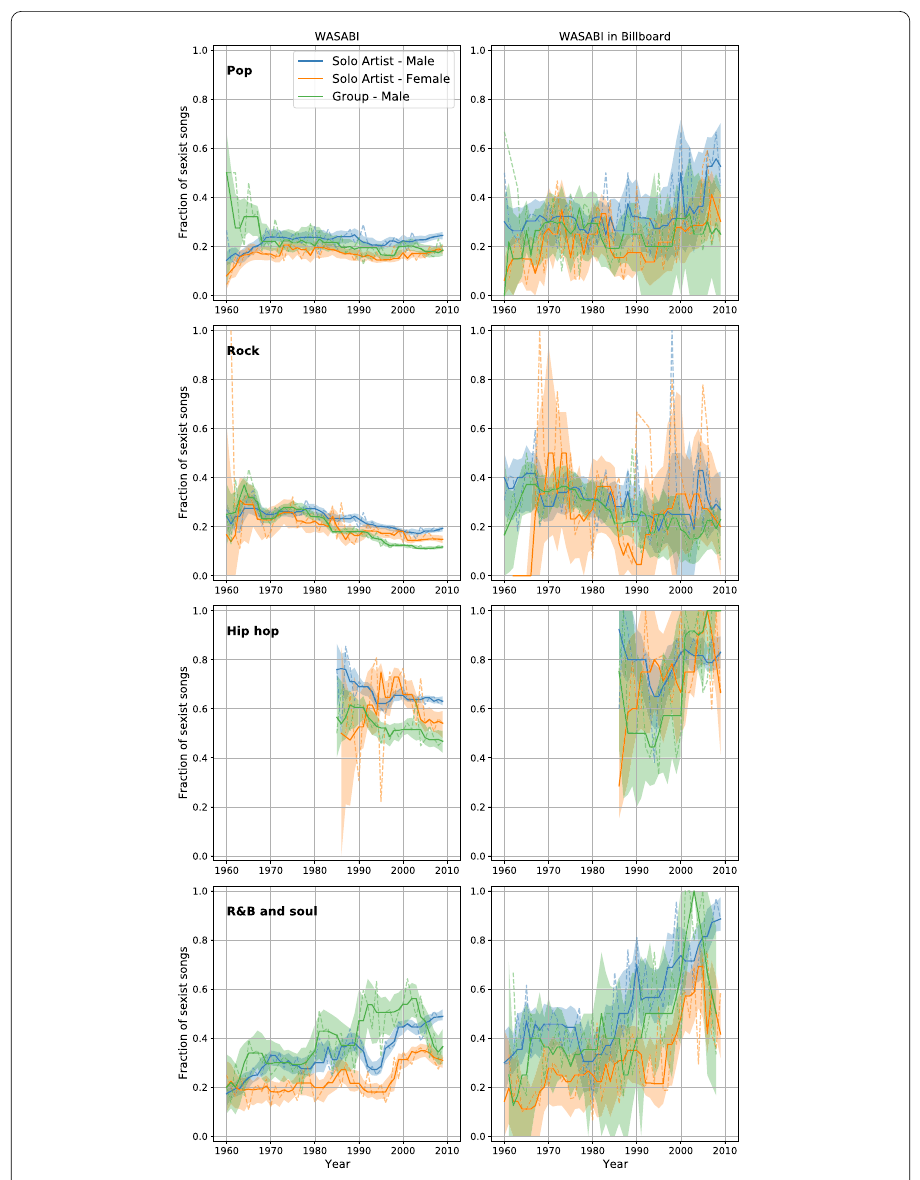
Figure 4 Fraction of songs containing sexist content. Each row refers to a genre and columns to two subsets of the WASABI dataset. Details as in Fig. 3